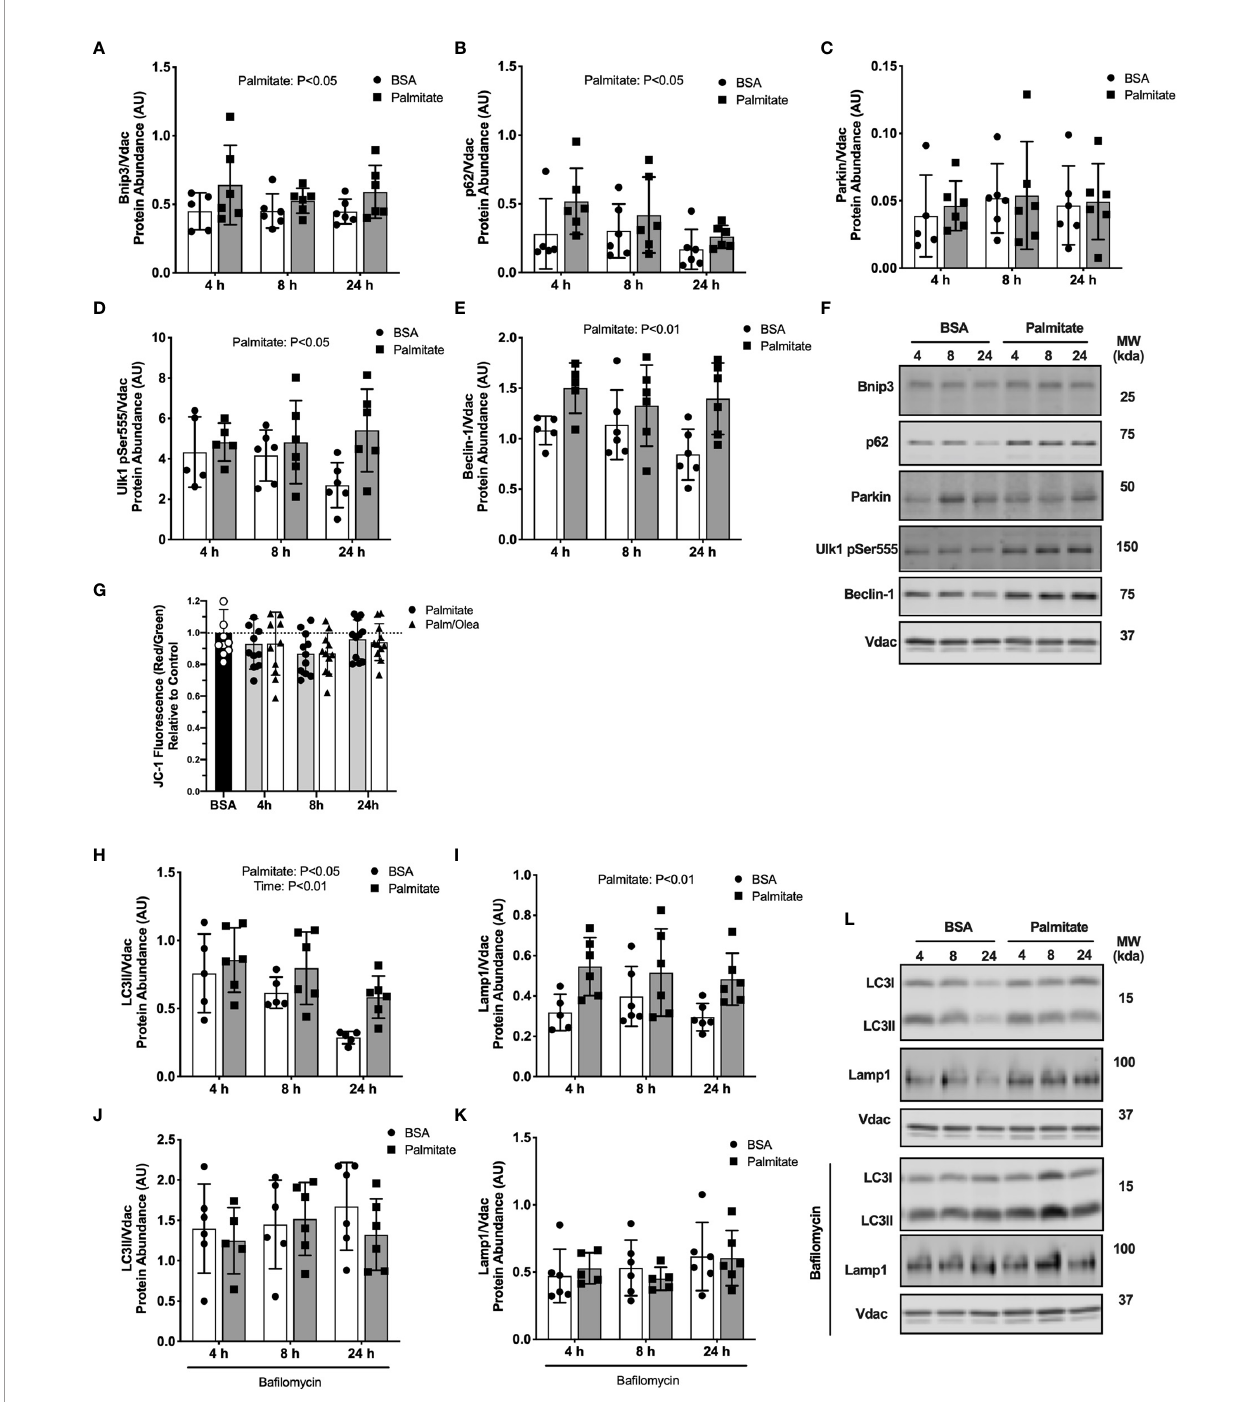
FIGURE 5 | Palmitate treatment in myotubes activated mitophagy. Autophagy protein markers in C2C12 myotubes treated with palmitate for 4, 8, or 24 hours. Cell lysates were fractionated to prepare a mitochondrial-enriched fraction for immunoblotting of Bnip3 (A) p62 (B) Parkin (C) Ulk1 pSer555 (D) and Beclin-1 (E) . Representative blot images for (A – E) (F) . JC-1 fl uorescence indicating mitochondrial membrane potential (G) . Mitochondrial localized LC3II (H) and Lamp-1 (I). Cells were treated with ba fi lomycin to inhibit autophagosome formation then mitochondria isolated and probed for LC3II (J) and Lamp1 (K) . Representative blot images for (H – K) (L) . Protein targets in the mitochondrial fraction are normalized to Vdac abundance as a mitochondrial protein control. Data are means ± SD; n=5-6 for immunoblots and n=11 for JC-1. Two-way ANOVA was used to test for effects of diet and time. Unpaired t-tests were used to test for JC-1 differences. P values are main